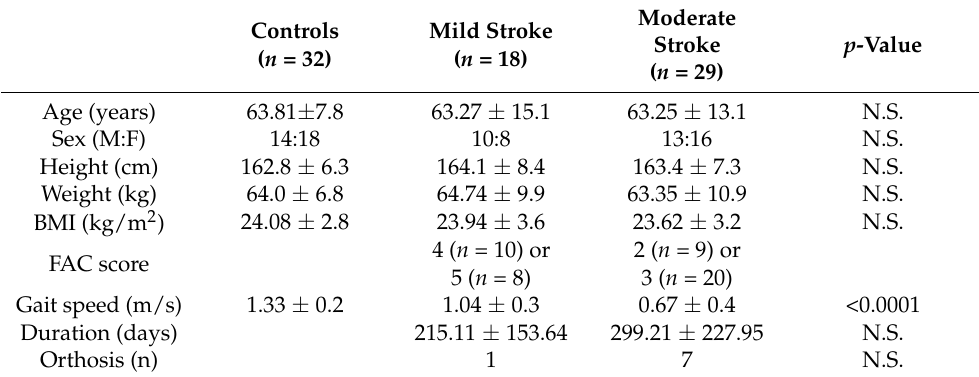
Table 1. Demographic data. The results are presented as mean ± standard deviation, or n . p -values were calculated by Kruskal–Wallis and Fisher’s exact